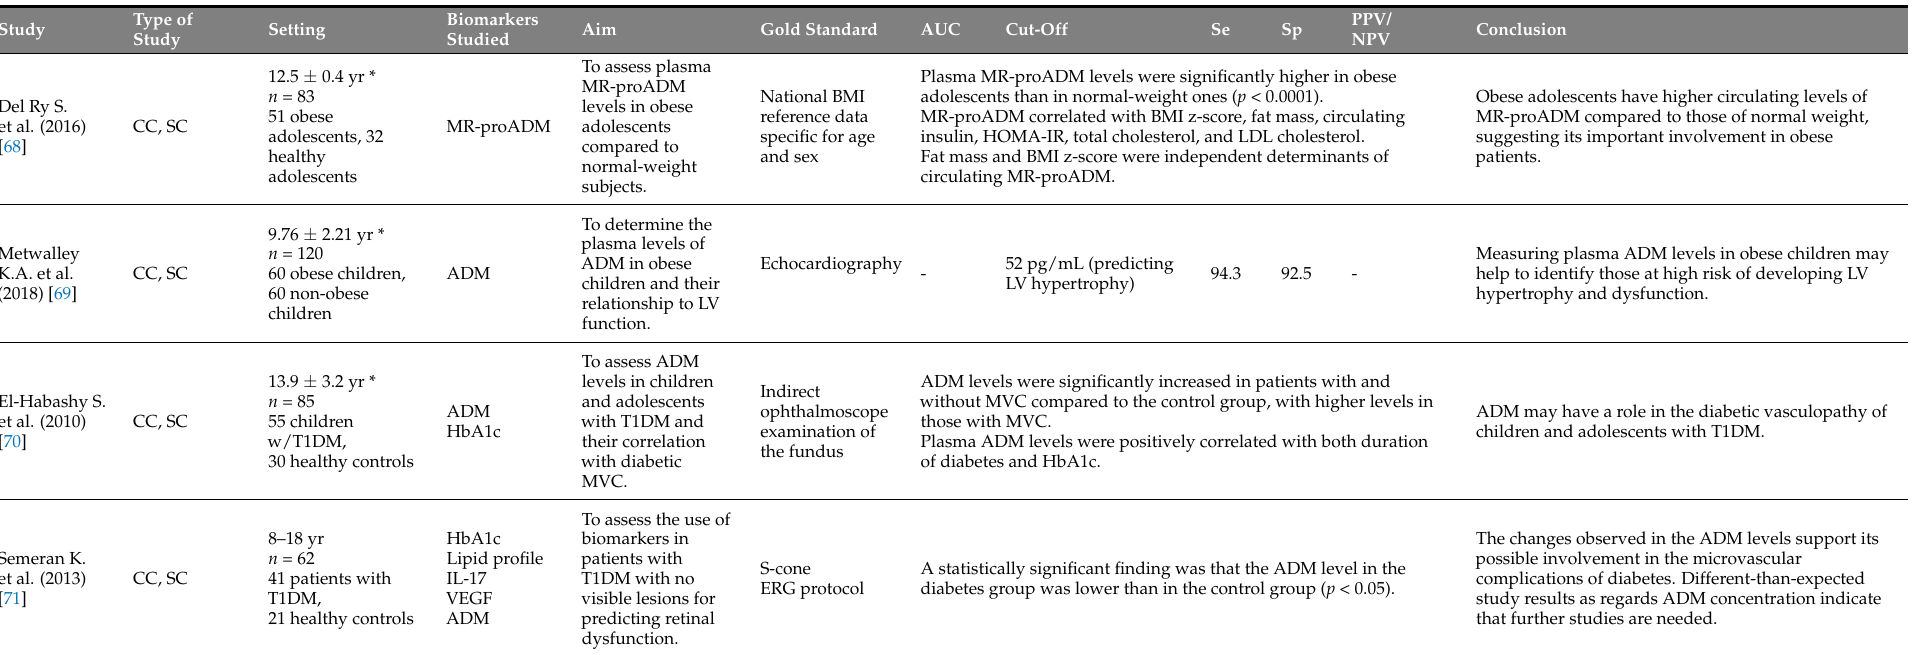
Table 5. Adrenomedullin and endocrine